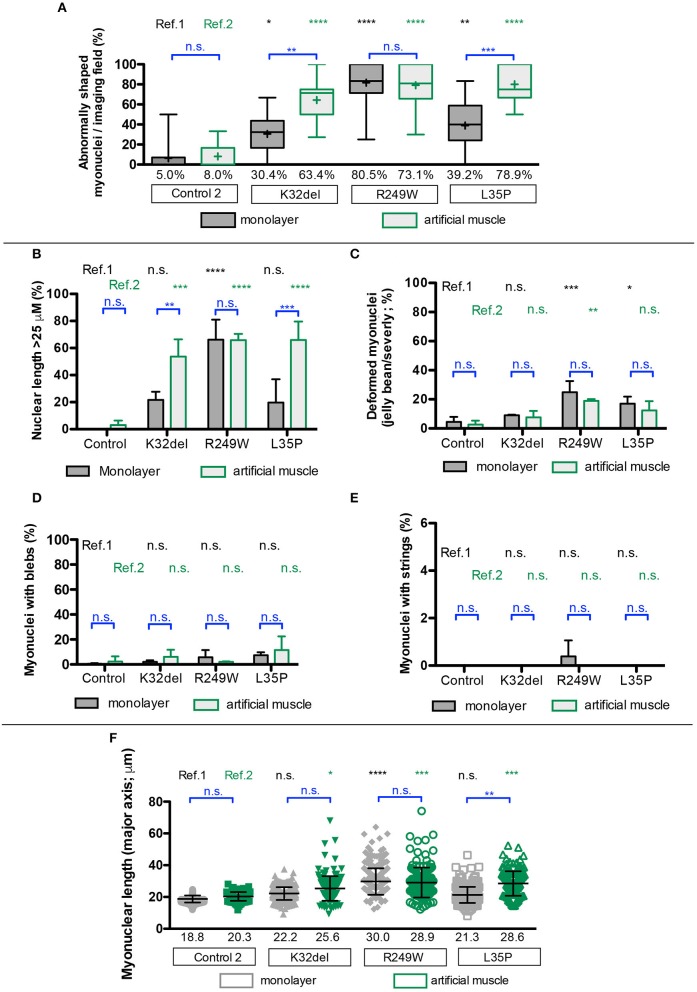
Disease-associated nuclear abnormalities are more prevalent upon terminal myogenic differentiation of LMNA-mutant iPSCs in three-dimensional cultures. (A) Abnormal K32del, R249W, and L35P myotube nuclei were assessed from the three dimensional computer-generated reconstructions shown in Figure 6, based on shape abnormality criteria established in 2D image analysis in LMNA-mutant HIDEMs (Figure 2). Three statistical comparisons of the myonuclei are shown: LMNA-mutant to control within monolayer culture (ref.1, black), within artificial muscles LMNA-mutant to control (ref.2, green), within each line comparisons between 2D and 3D artificial muscle (blue). Data analyzed together using two-way ANOVA with Tukey's post-hoc comparisons for comparisons to control, and Sidak's for comparisons within lines on the average of three passages (n = 3, for monolayer cultures 82–154 myonuclei were analyzed per passage per cell line with a total of 272–410 per cell line, for artificial muscle 37–70 nuclei were analyzed, totaling 124–171 per cell line). Data are shown as box plots of proportion of abnormal nuclei per imaging field from all three repeats (22–44 total imaging fields per cell line combined from three repeats); whiskers: minimum and maximum values, +: average of all imaging fields. Values shown on graph: average of three repeats used for statistical analysis. (B–E) Quantification of the different types of shape abnormality shown in (A), based on criteria established in LMNA-mutant HIDEMs (Figure 2). As in (A), three types of comparisons are shown. Nuclei with more than one type of shape abnormality (e.g., blebs and elongation) were counted twice, therefore totals can exceed 100%. Data analyzed together using two-way ANOVA with Tukey's post-hoc test for comparisons to control, and Sidak's post-hoc test for comparisons within lines (n = 3). (F) Myonuclear length along the major nuclear axis. As in (A), three types of comparisons were performed. Data analyzed using two-way ANOVA with Tukey's post-hoc test for comparisons to control, and Sidak's post-hoc test for comparisons within lines (n = 3). Data are shown as a scatter plot comprised of all values from three repeats combined. Bars: mean and standard deviation. Nuclei were assessed to be part of a myotube based on location within a multinucleated myosin/titin-positives structure, and nuclear exclusion of myosin/titin. Data for non-myotube nuclei within the culture are not shown. *p < 0.05, **p < 0.01, ***p < 0.001, ****p < 0.0001.